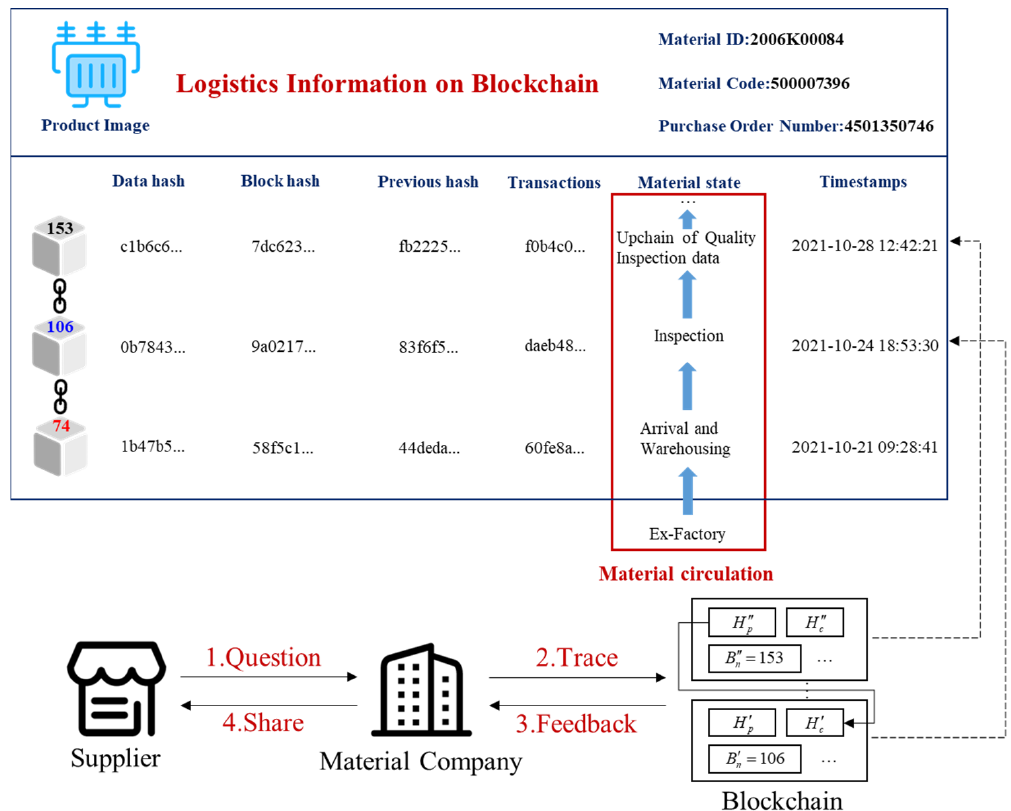
Figure 7. Power material data traceability process based on Hyperledger Fabric.